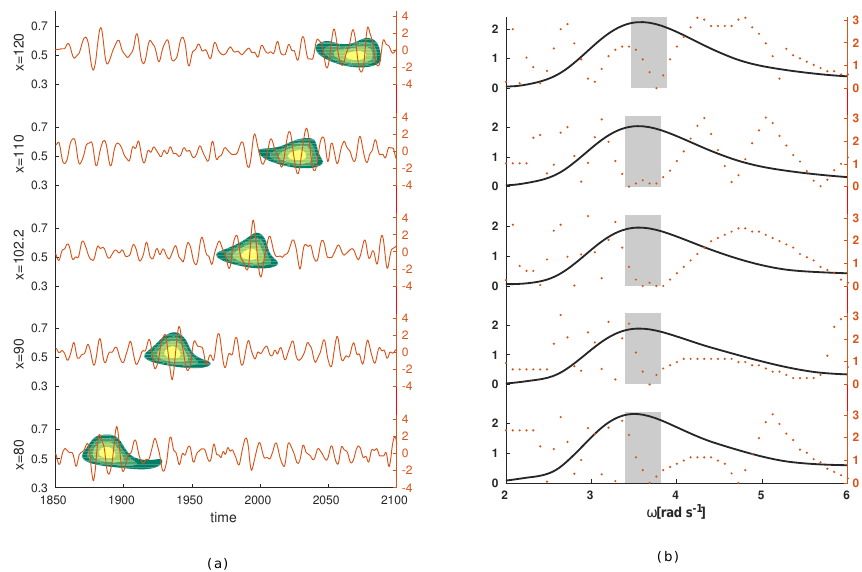
Figure 23. Case IW12. (a) Time signals at various positions of the evolution of the critical group event with the filled contour plot of wavelet spectra. (b) The corresponding time-averaged wavelet spectra (solid line) and the time spreading (dotted line). The shaded areas show the chosen frequency interval of the most energy-carrying modes.